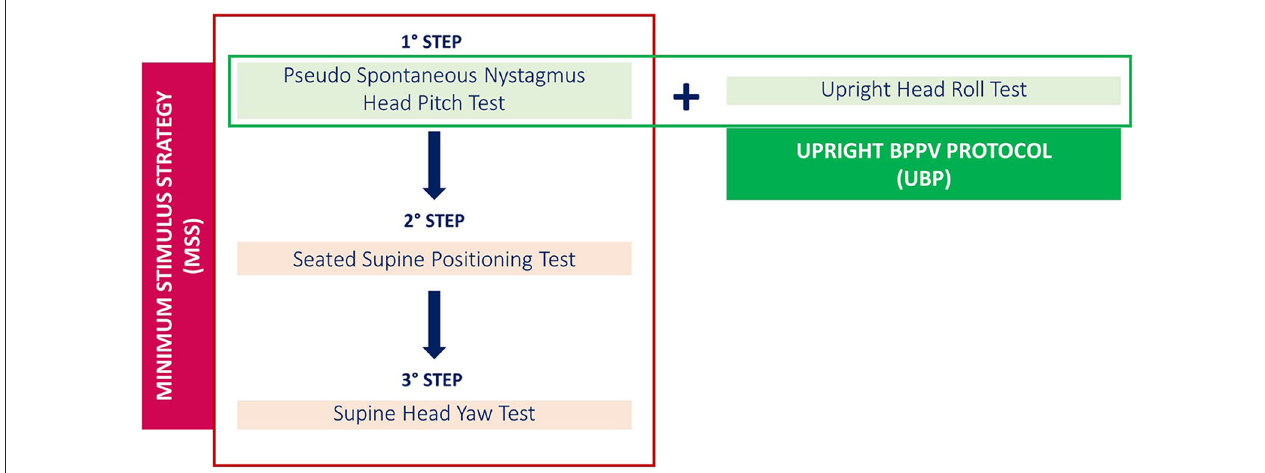
FIGURE 1 | Diagnostic algorithm for LSC-BPPV: minimum stimulus strategy (MSS) and upright BPPV protocol (UBP).